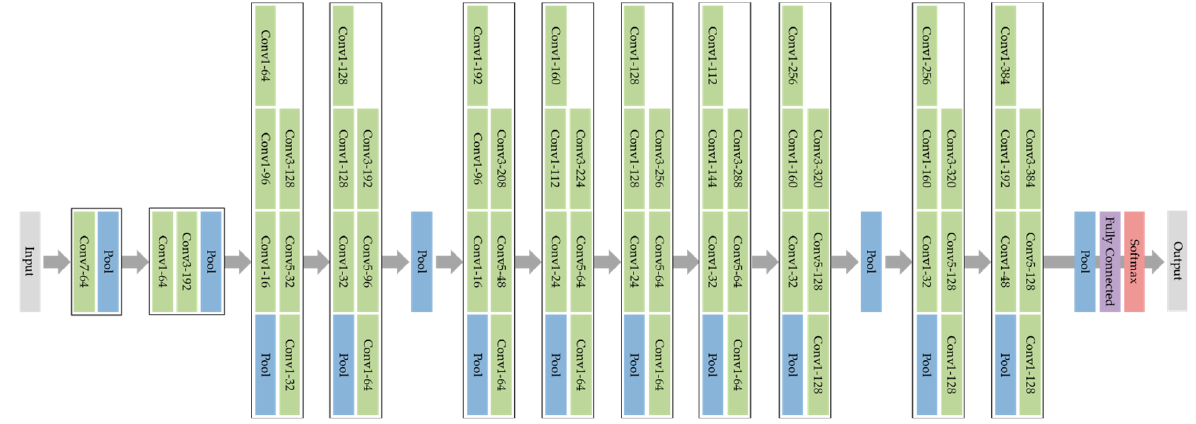
Figure 6. GoogLeNet architecture composed of a mixture of convolutional (green), pooling (blue) softmax (red) and fully connected (purple) layers.